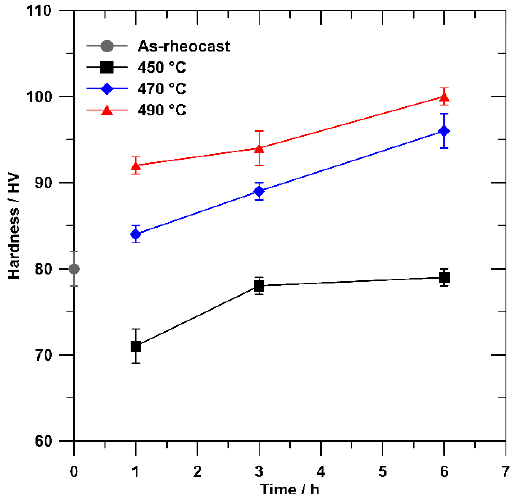
Figure 12. Hardness of rheocast AlSi9Cu3(Fe) alloy as function of solution temperature and time.